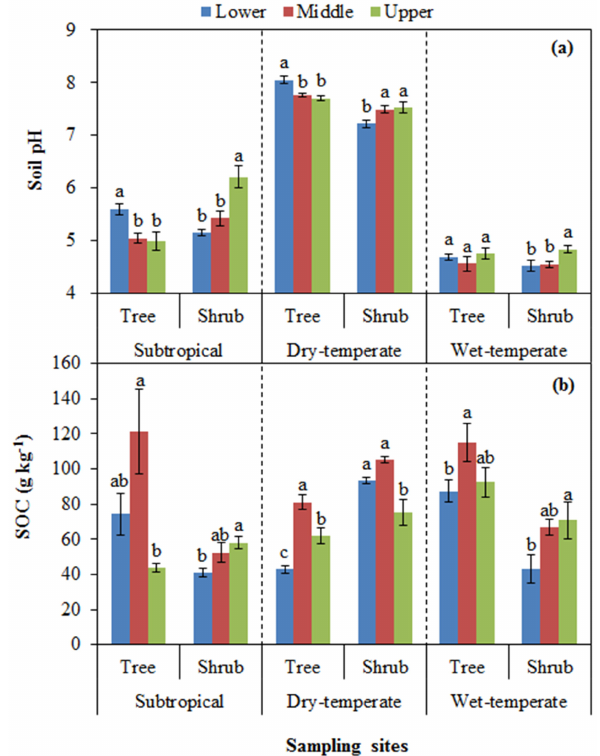
Figure 1. Soil pH values (a) and soil organic carbon (SOC) con- centration (b) at lower and middle elevations as well as at the upper limit of tree and shrub lines for each of the three sites. Different let- ters indicate significant differences among three elevations within tree and shrub lines for each